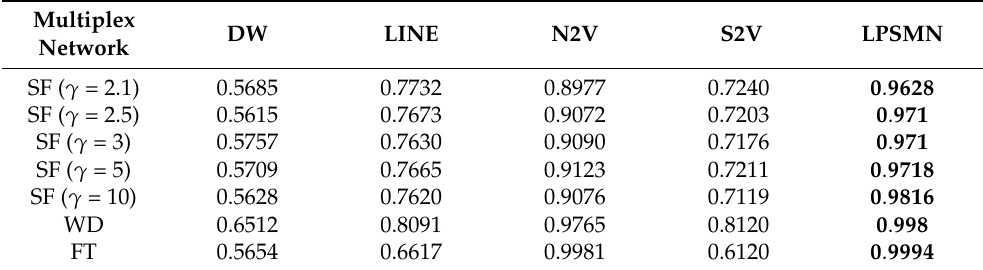
Table 3. Comparison with latent feature methods